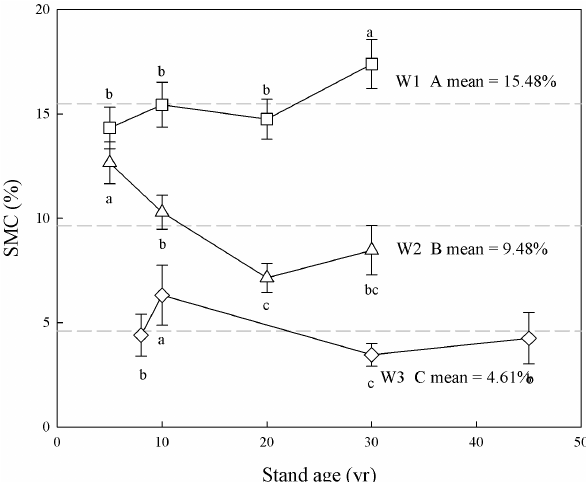
Fig. 6. SMC versus stand age for the different watersheds. The bars indicate the standard deviations of the means. Lowercase letters indicate differences between depth-averaged SMCs with different stand ages for a given watershed, significant at the 0.05 level. Up- percase letters after W1, W2 and W3 indicate differences between watershed-averaged SMCs significant at the 0.05